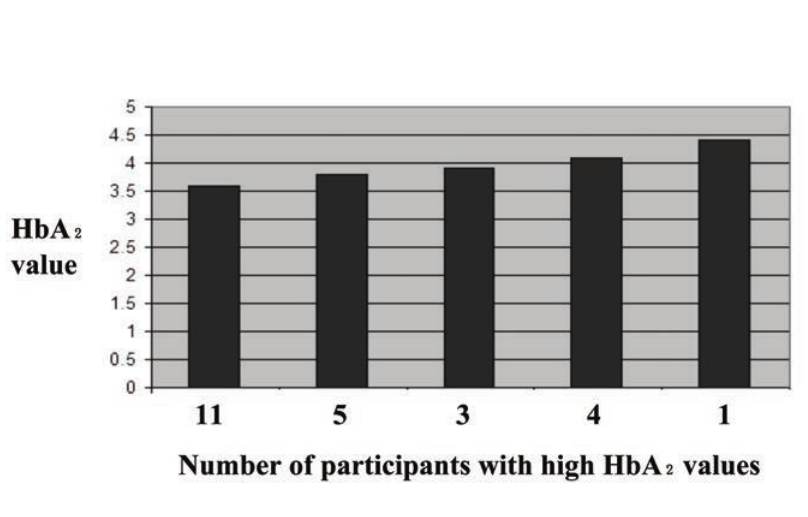
Figure 1. b carrier with normal hemoglobin A ume; MCH, mean cell hemoglobin; RdW, red cell distribution width.